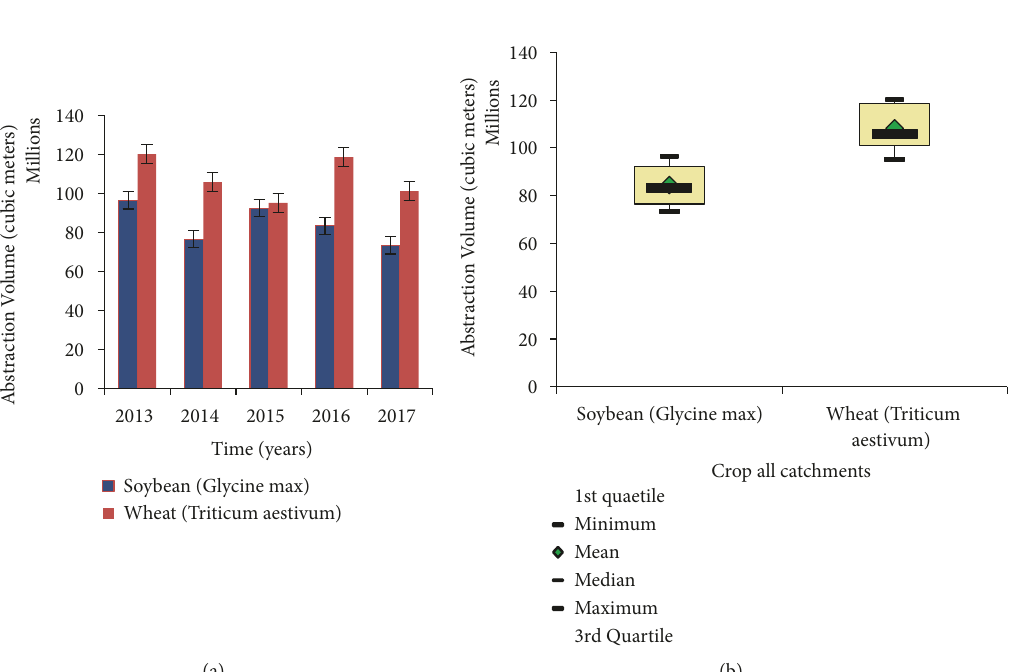
Figure 5: (a) Total annual abstraction volumes and (b) average annual for each